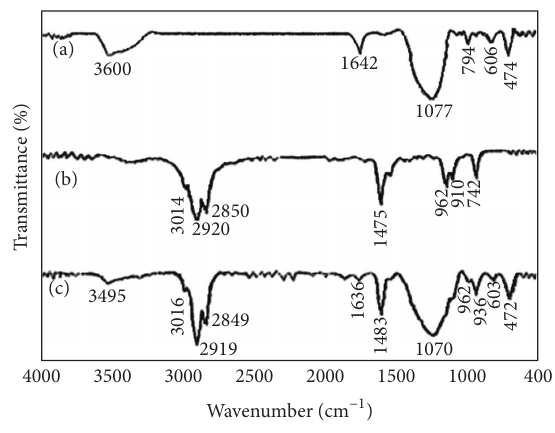
F 2: FT-IR patterns for (a) the prepared zeolite nanoclinop- tilolite, (b) HDTMA and (c)